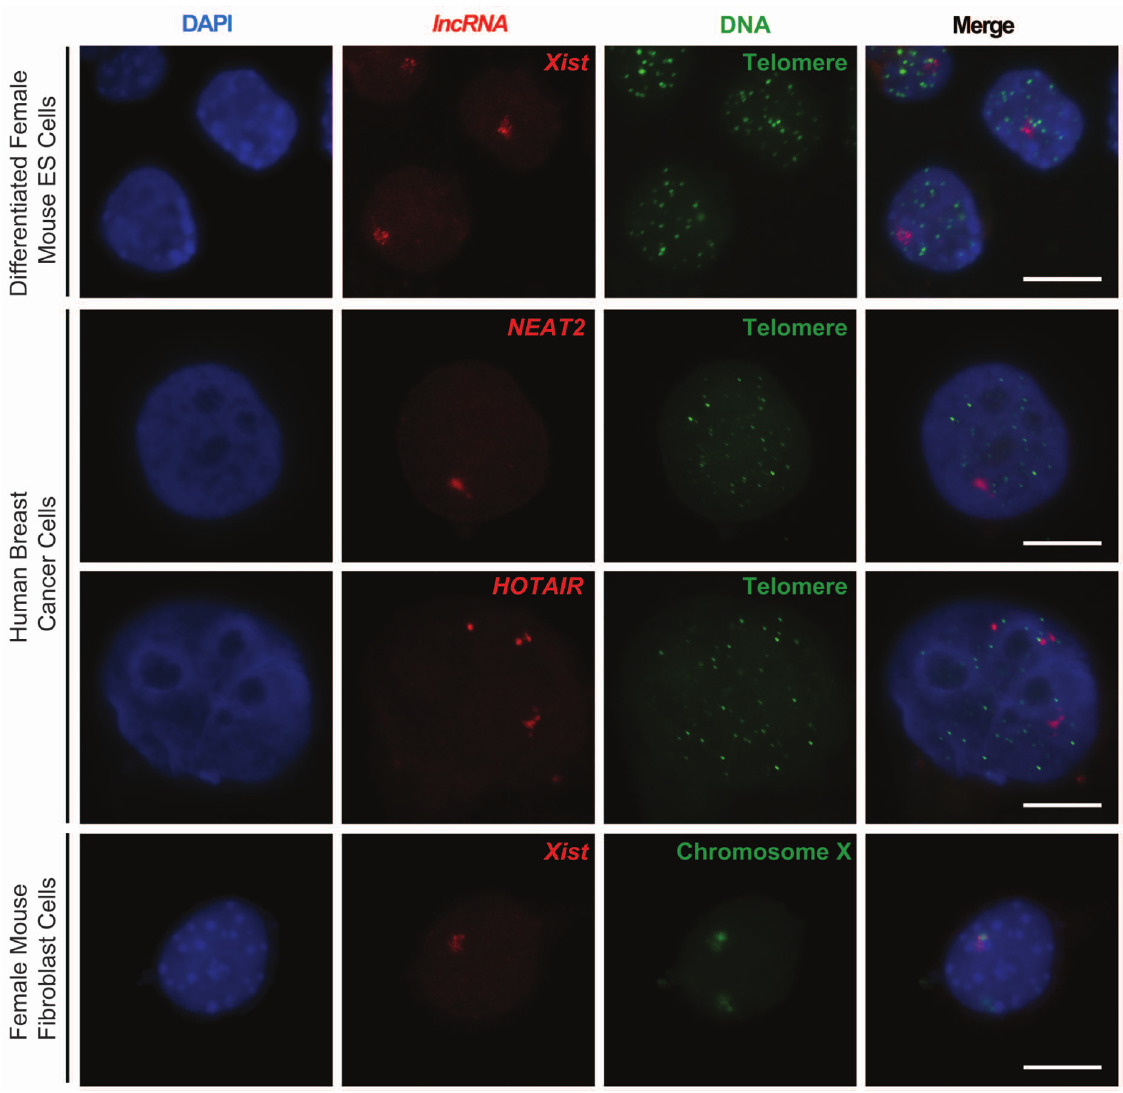
Figure 3. RNA-DNA FISH using amino-labeled probes generated by nick translation. Nuclei were stained by DAPI (blue). Three lncRNAs ( Xist , HOTAIR and NEAT2 ) were detected using Cy3-labeled probes (red). Telomere DNA regions were detected using FITC-labeled oligonucleotide probes (green). Chromosome X territory was detected by FITC-labeled chromosome X paint (green) in DNA FISH. A scale bar of 10 m m is shown.